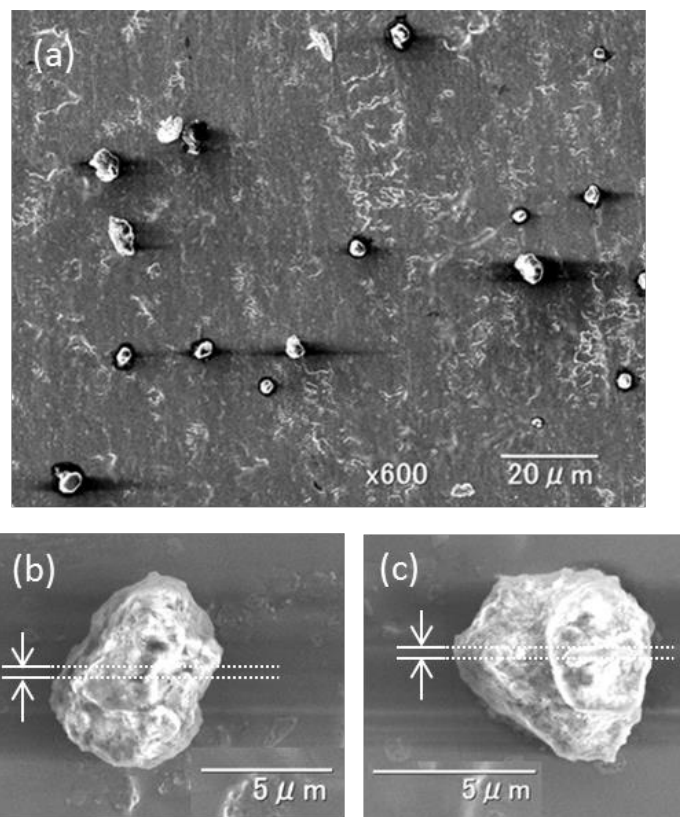
Figure 2. ( a ) Example SEM image of particles collected on the Ti plate during the dust event. SEM images of the dust particles were sliced by the focused ion beam (FIB) milling and were used for additional TEM and selected-area electron diffraction (SAED) analyses. ( b ) Dust Particle 1 and ( c ) Dust Particle 2. Cross-sections between the broken lines were used for detailed TEM analyses.